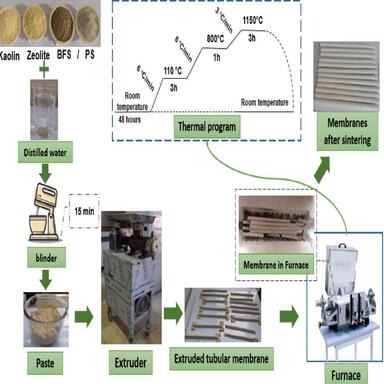
Schematic of preparation process of slag-based tubular membranes.